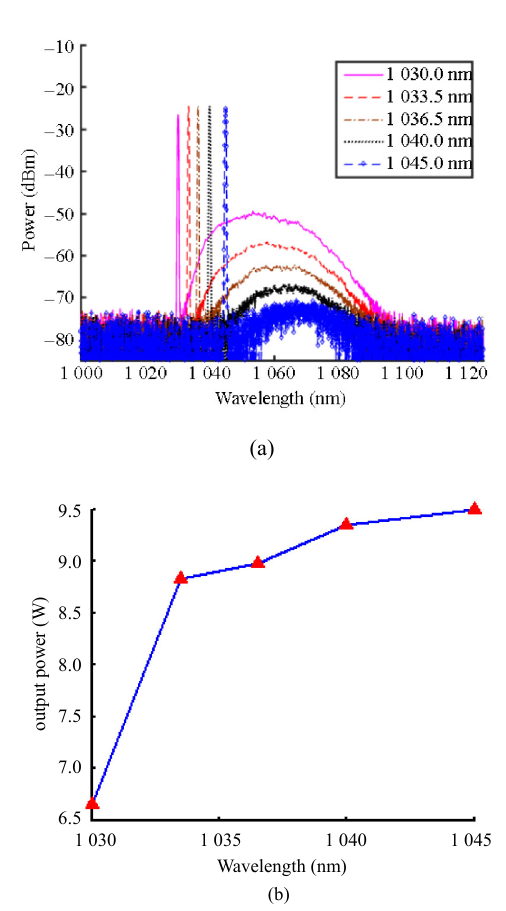
Fig. 2 Experimental results of the tunable pump laser: (a) spectra from 1030 nm to 1045 nm and (b) output power as a function of the